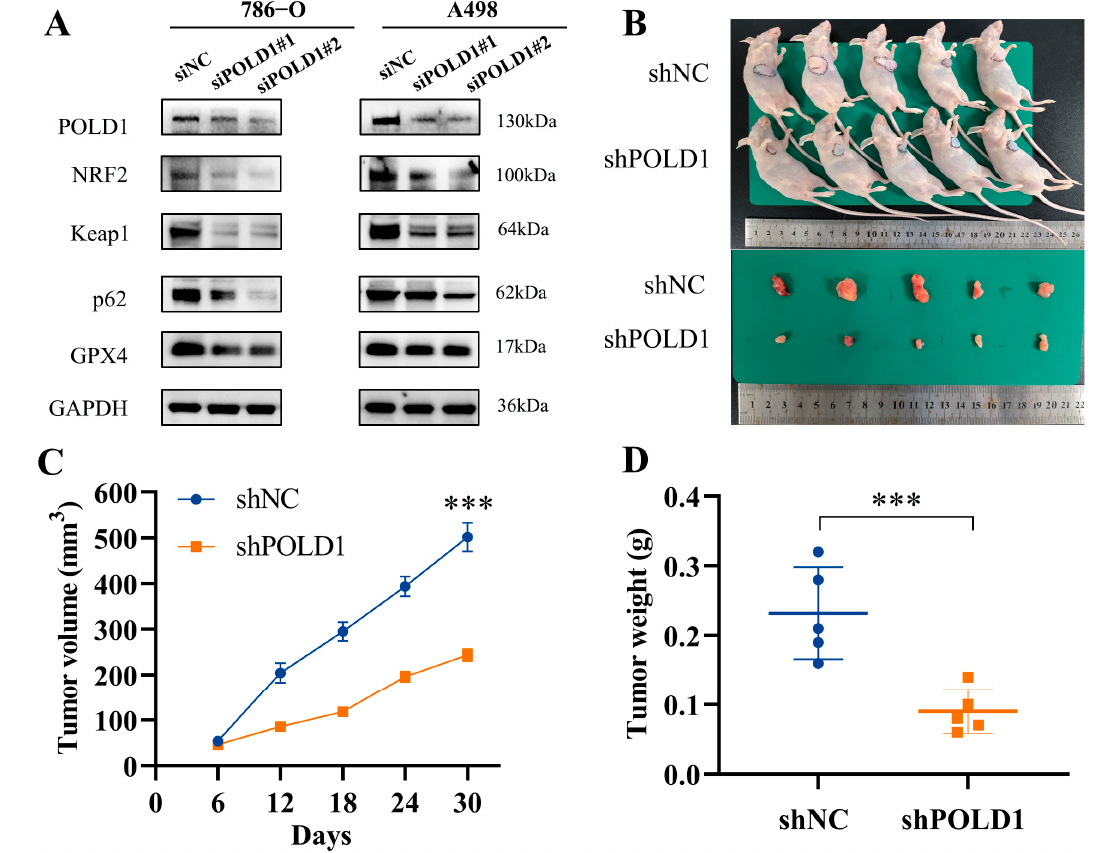
Figure 9. Oncogenic signaling pathways in ccRCC cells and tumor growth in xenograft mouse model after POLD1 knockdown. ( A ) Western blot analysis of Autophagy and Ferroptosis pathway-related proteins with POLD1 knockdown in the 786-O and A498 cells. Tumor growth curve ( C ) of stable POLD1 knockdown 786-O cells (or negative control) in the xenograft mouse model was presented, followed by the collection of tumor nodules ( B ) and tumor weight records ( D ). Differences were considered significant at p < 0.05 (*** p < 0.001).